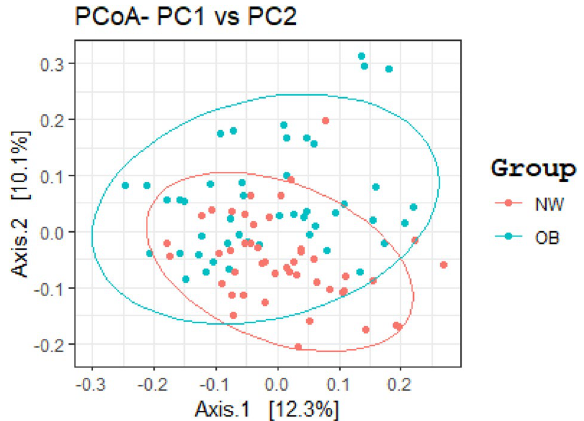
Figure 1. GM beta diversity analysis of OB patients compared to NW. Principal Coordinates Analysis (PCoA) based on Bray–Curtis distance matrix, performed in R software v.3.5.2 (ggplot2 package), showed a marked separation between the GM communities of OB and NW. The statistical significance among the two groups was determined with Permutational Multivariate Analysis of Variance (PERMANOVA) (R-vegan, function adonis), adjusted for sex, age and smoking status (sum of squares = 0.5492, mean of squares = 5.0297, F = 0.0533, R = 0.047, p = 0.002). p equal to or less than 0.05 was considered statistically significant.